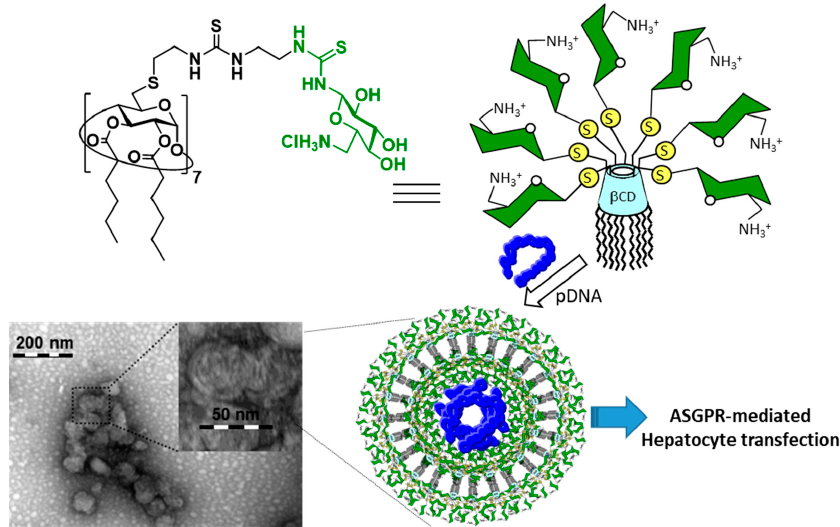
Figure 17. Structure of the 6-amino-6-deoxy β -D-glucopyranosylthioureido/ β CD conjugate prepared by Jiménez Blanco, Di Giorgio and coworkers, and an illustration of their co-assembly with pDNA to form nanocomplexes that promoted ASGPR-mediated transfection of hepatocytes [170,171]. A representative TEM micrograph of the nanocomplexes is also shown. Adapted with permission from Reference [170]. Copyright Centre National de la Recherche Scientifique (CNRS) and Royal Society of